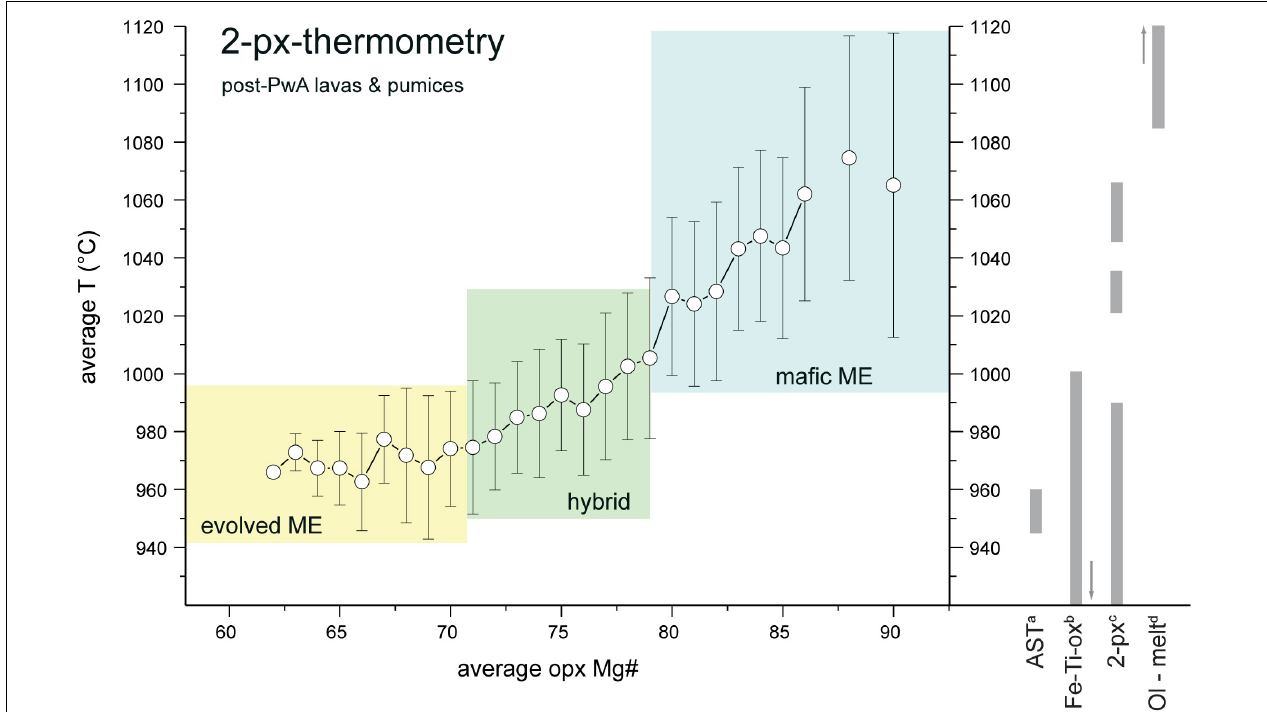
FIGURE 7 | Average temperature vs. average opx Mg# for all post-PwA pyroxenes of the PVC, calculated using the 2-px thermometer after Putirka (2008; eq. 36). Errors are 1 SD uncertainties. Color-shaded fields designate compositional ranges for the evolved (yellow) and mafic (blue) magmatic environment (ME) as well as hybrid compositions (green). For comparison, constraints from literature on PVC temperatures using various thermometers are shown as gray bars to the right. a – apatite saturation temperatures (AST; Witter et al., 2005). b – Fe-Ti-oxide thermometry (Schaaf et al., 2005; Witter et al., 2005; Sosa-Ceballos et al., 2012). c – 2-pyroxene-thermometry (Straub and Martín-Del Pozzo, 2001; Witter et al., 2005; Sosa-Ceballos et al., 2012). d – Ol-bulk melt thermometry (Straub and Martín-Del Pozzo, 2001; Roberge et al.,